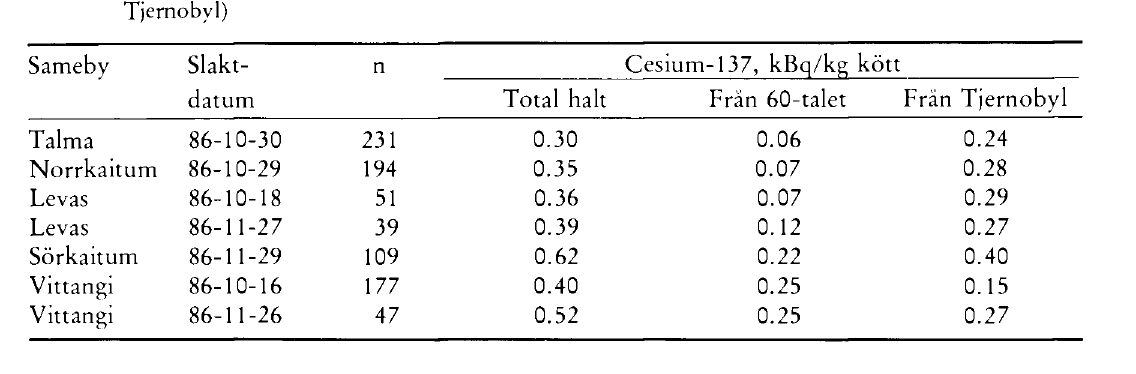
Tabell 1. Cesium-137 i renkött från några slakter i Norrbotten hosten 1986 (från 1960-talet